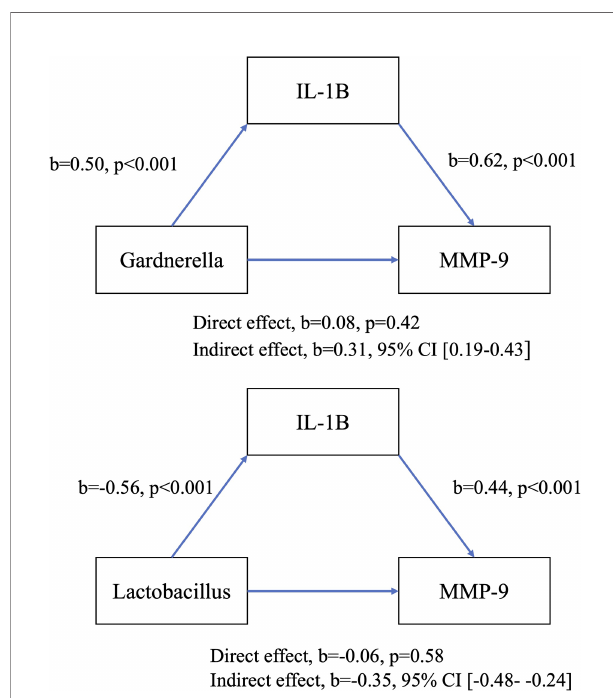
FIGURE 6 | Model of direct and indirect relationships between MMP-9, key bacterial genera and IL-1 b .